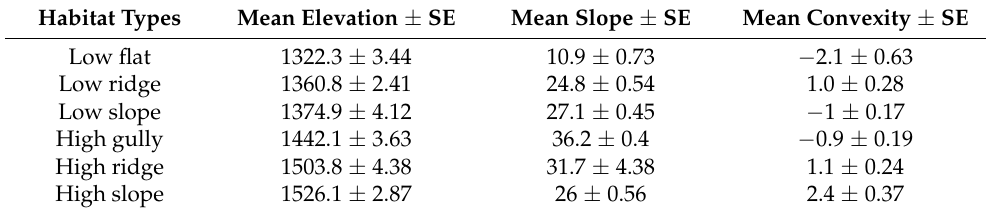
Table 1. Six habitats classified in this study.